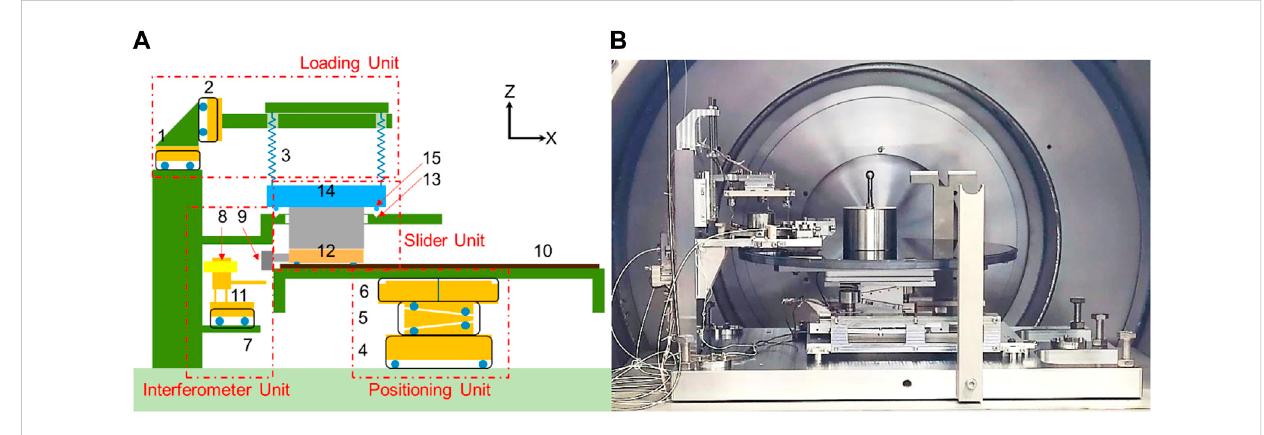
FIGURE 1 The pre-sliding tribometer. (A) Schematic of the setup. (B) picture of the